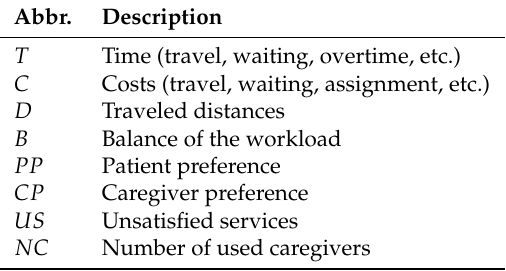
Table 1. Common types of optimization criteria.